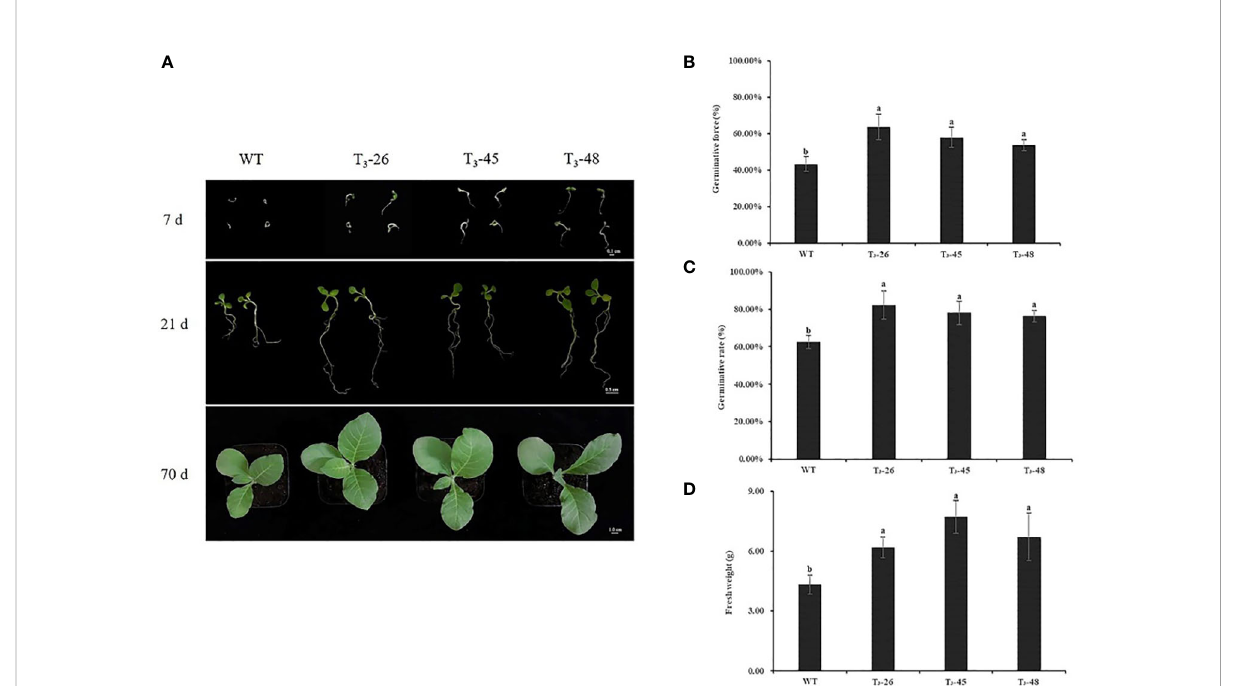
FIGURE 3 The phenotypic analyzes of NtCPS2 transgenic plants and WT plants. (A) Phenotype of WT and transgenic seeds sown for 7, 21, and 70 days, respectively. (B) Germinative force of WT and transgenic seeds sowed for 7 days. (C) Germinative rate of WT and transgenic seeds sowed for 14 days. (D) Fresh weights of 70-day-old WT and transgenic plants. Bars = 0.1 cm, 0.5 cm or 1.0 cm. Error bars represent means ± SD. Statistical analysis was performed using the ANOVA test (p< 0.05) and signi fi cant differences are indicated by different letters. .